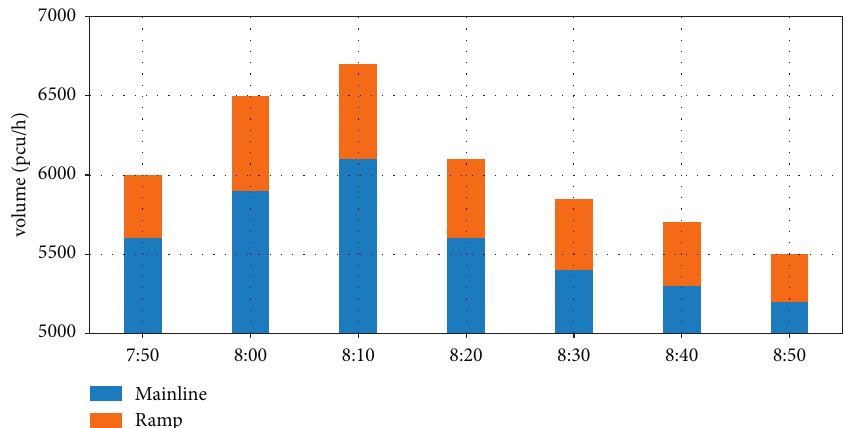
Figure 6: Traffic volumes in the mainline and the on-ramp.